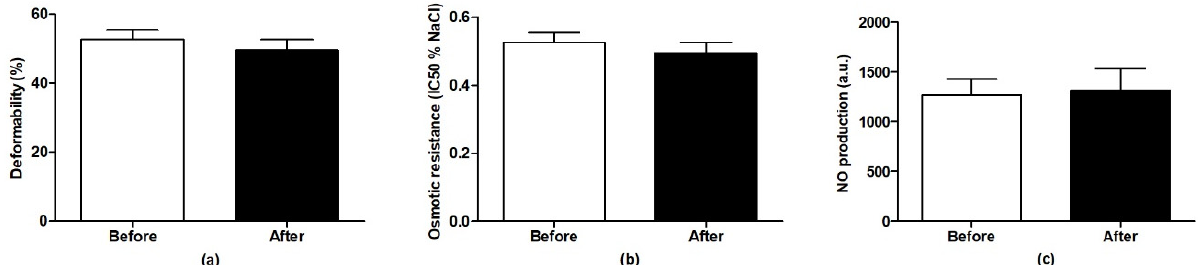
Figure 6. ( a ) Red blood cell deformability, ( b ) osmotic resistance, and ( c ) nitric oxide production in spontaneously hypertensive rats before and 100 min after Fe 3 O 4 @PEG-Ale nanoparticle infusion. The values represent the mean ± SEM, n = 3 (deformability and osmotic resistance), n = 5 (NO production).